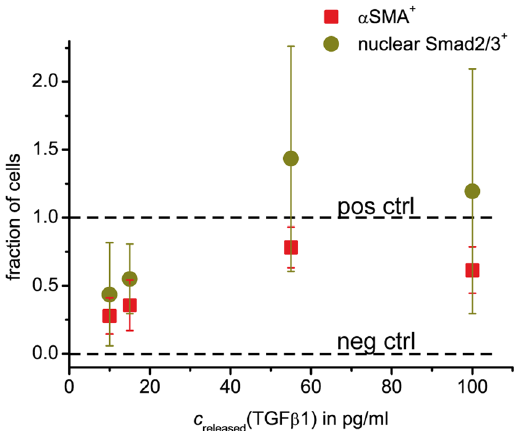
Figure 5. TGF β 1 delivery in paracrine manner leads to dose-dependent myofibroblast differentiation. Myofibroblast differentiation correlates with TGF β 1 loading concentration of µ -beads and thereby with delivered TGF β 1 concentration. Myofibroblast differentiation was quantified by Smad2/3 nucleus (nuclear Smad2/3 + ) and fibrillar α SMA ( α SMA + ) staining. Fraction of Smad2/3 + and α SMA + cells were normalized to positive control (10 ng/ml TGF β 1 systemic) as 1 and negative control (no additional TGF β 1) as 0. Data are presented as mean ± standard deviation. Experiments were done in triplicate, each experiment with fibroblasts from a different donor. For each condition, about 100 cells were